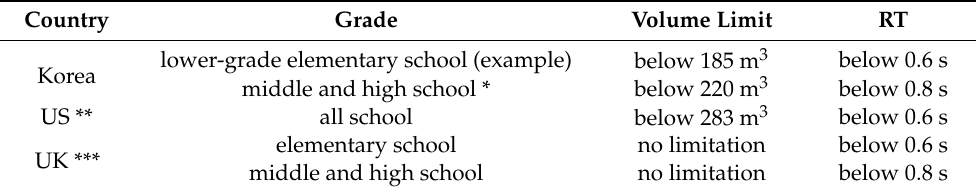
Table 13. Comparison of reverberation time standards in various countries.